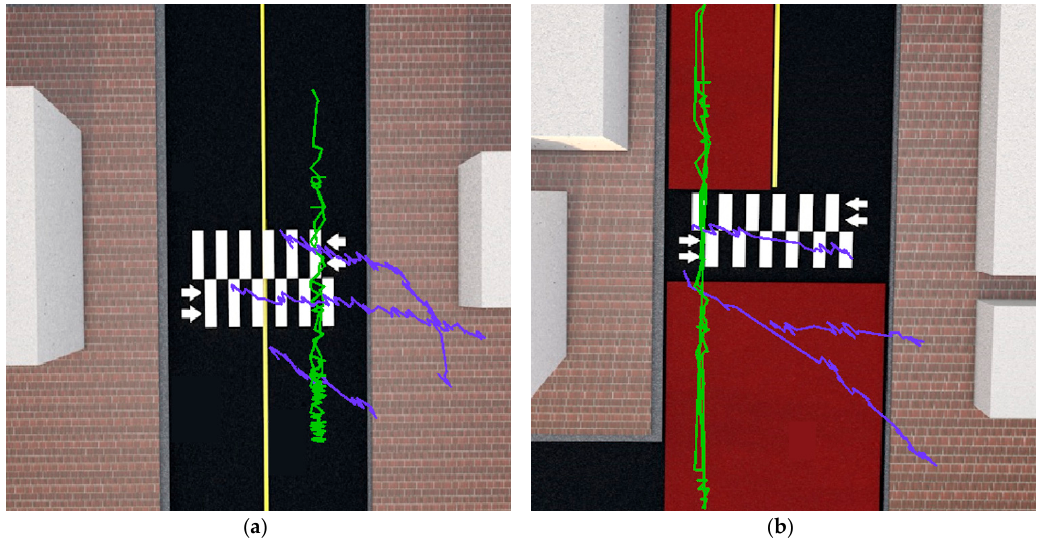
Figure 2. Diagrams of objects’ trajectories in ( a ) spot A; and ( b ) spot B in overhead view.